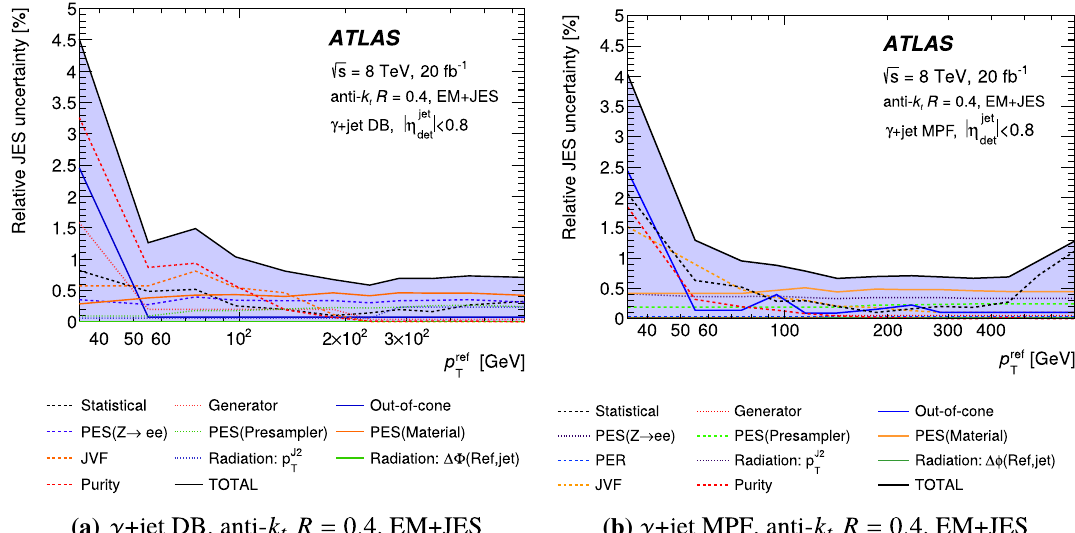
Fig. 27 Summary of the JES statistical and systematic uncertainties evaluated for the γ +jet a DB and b MPF analyses for anti- k t jets with R = 0 . 4 and calibrated with the EM+JES scheme. The total